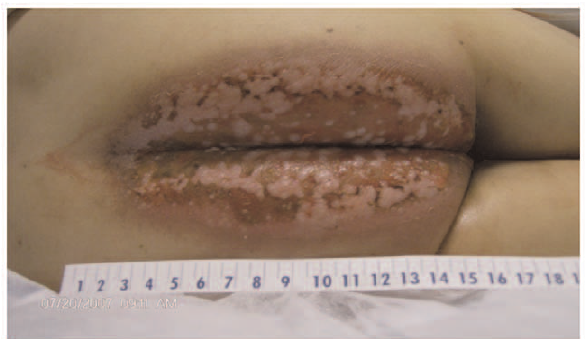
Figure 1. Severe skin reaction of a Dubowitz Syndrome patient to radiation therapy. Shown is the severe skin injury on the anal- rectal region after 10 fractions of 2 Gy radiation-therapy for anal cancer. The patient died of the metastatic anal cancer